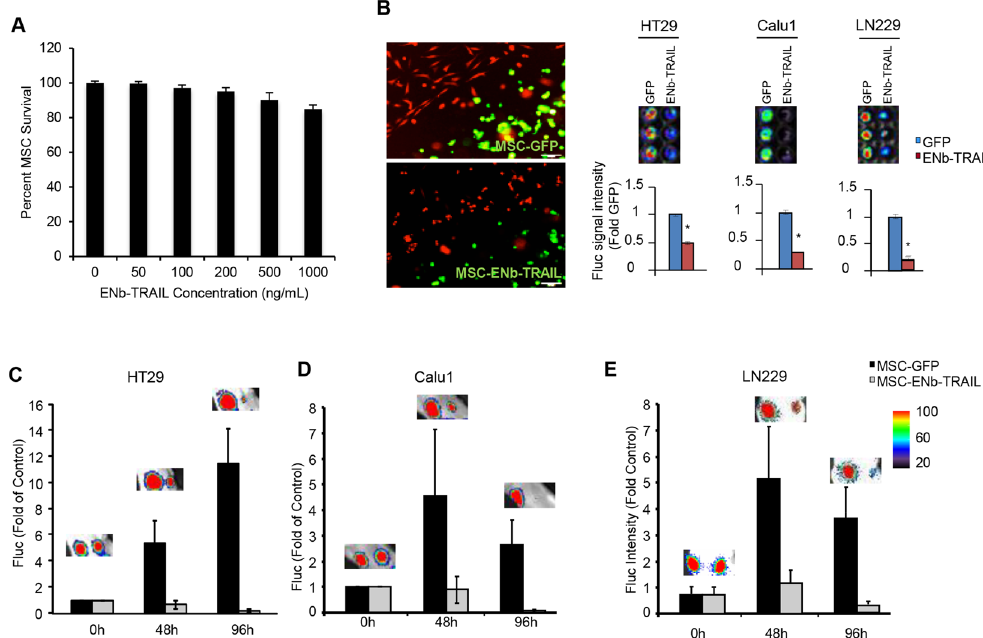
Figure 4. Therapeutic stem cell delivered ENb-TRAIL is effective in vitro and in vivo . ( A ) Plot showing the response of human MSC to different concentrations of ENb-TRAIL. ( B ) Tumor cells were engineered with FmC and tumor cell viability was visualized by Fluc bioluminescence imaging 48 h post co-culture with MSC-GFP or MSC-ENb-TRAIL-IRES-GFP. Left panel: high magnification fluorescence images of co-culture; Right panel: Fluc bioluminescence images of co-culture and the quantification of Fluc signals. * P < 0.001 determined